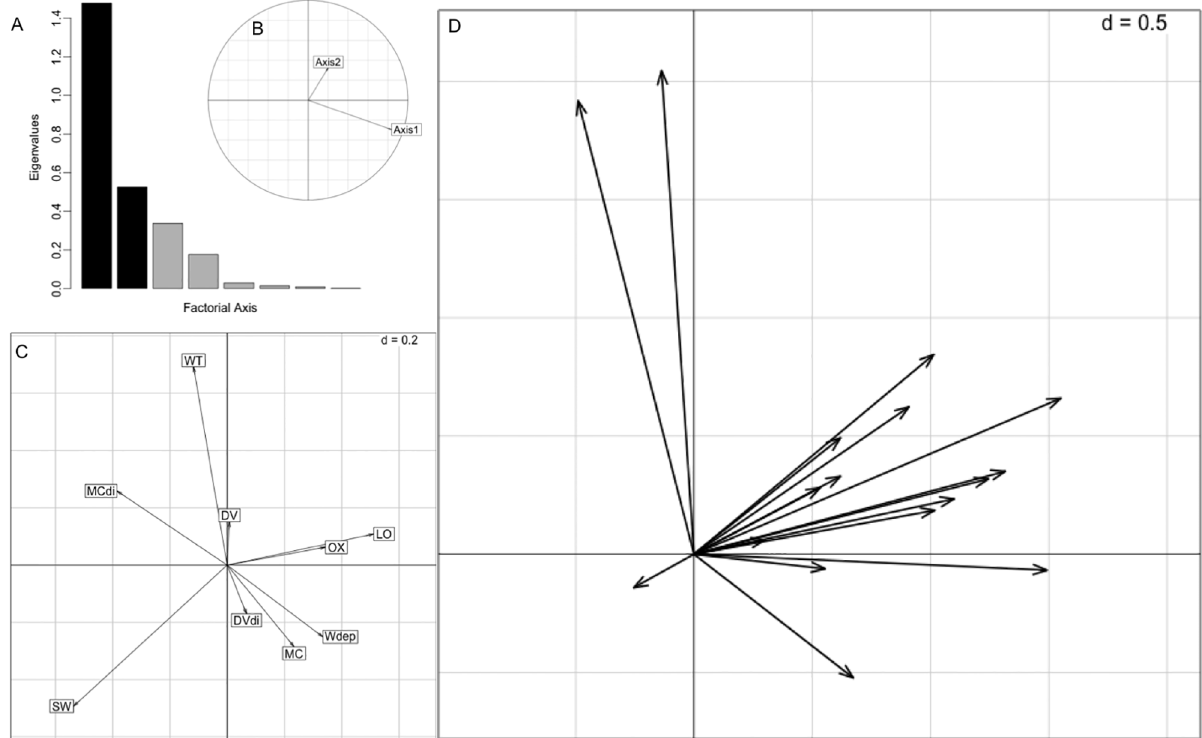
Fig 2. Home range level resource selection plots from the K-select analysis for radio-tracked adult male alligators at Ross Barnett Reservoir and the Pearl River, Mississippi, USA, 2012 – 2013. (A) Scree plot of eigenvalues where Axis 1 and 2 are shown as black bars and other axes are represented as gray bars. (B) Orthogonality plot for Axis 1 and 2. (C) Habitat variable loadings. Abbreviations of habitat variables: main channel (MC), backwaters and oxbow lakes (OX), floating, emergent vegetation (DV), lotus (LO), forest and swamps (SW), very shallow wetlands (WT), water depth (Wdep), distance to main channel (MCdi), and distance to floating, emergent vegetation (DVdi). (D) Marginality vectors of each animal that point from the centroid of available resource space to the centroid of used resource